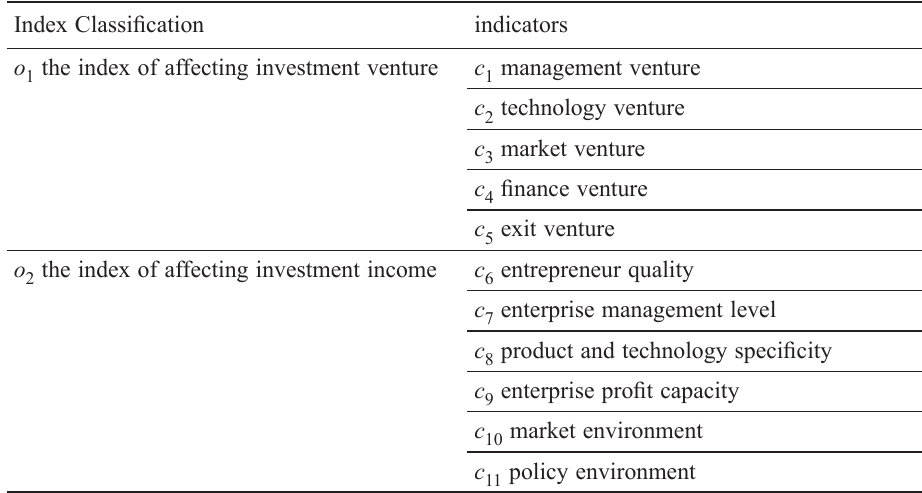
Table 2. Index system for venture investment